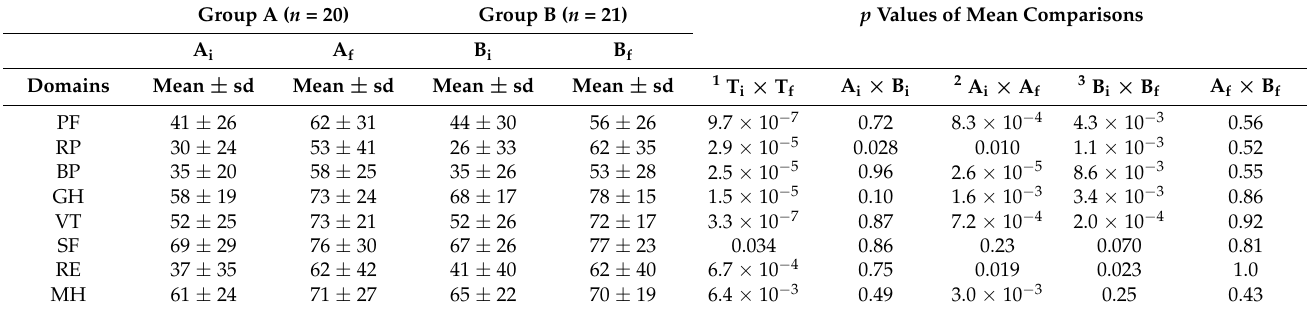
Table 3. Mean and standard deviation of patient scores in the Medical Outcomes Study Short Form 36 (SF-36) evaluation and p -values for comparisons between the beginning (i) and end (f) of the treatment for the whole group (T), and intra- and intergroup comparisons (A and B). Results are considered statistically significant for p < 0.05. Group A ( n =